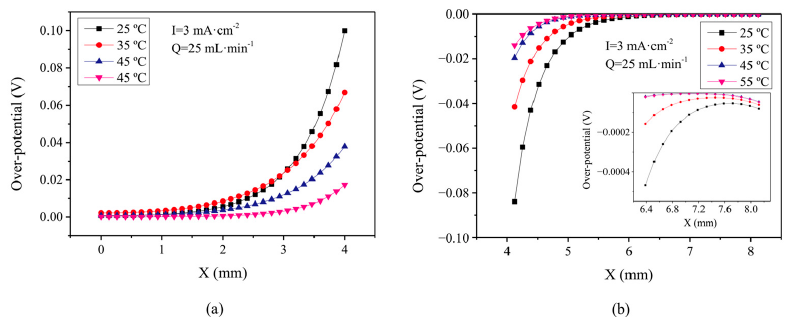
Figure 5. Distribution of over-potentials with different temperatures, where ( a ) and ( b ) represent the negative and positve electrode respectively [40].